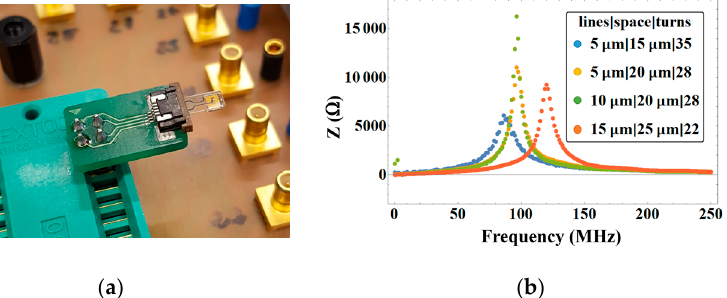
Figure 3. ( a ) Measurement setup for electrical microcoil characterization; ( b ) Real part of impedance curves measured for four different microcoils. Table 1. Extracted electrical characteristics of four different microcoils compared to simulation. Lines | Space | Turns